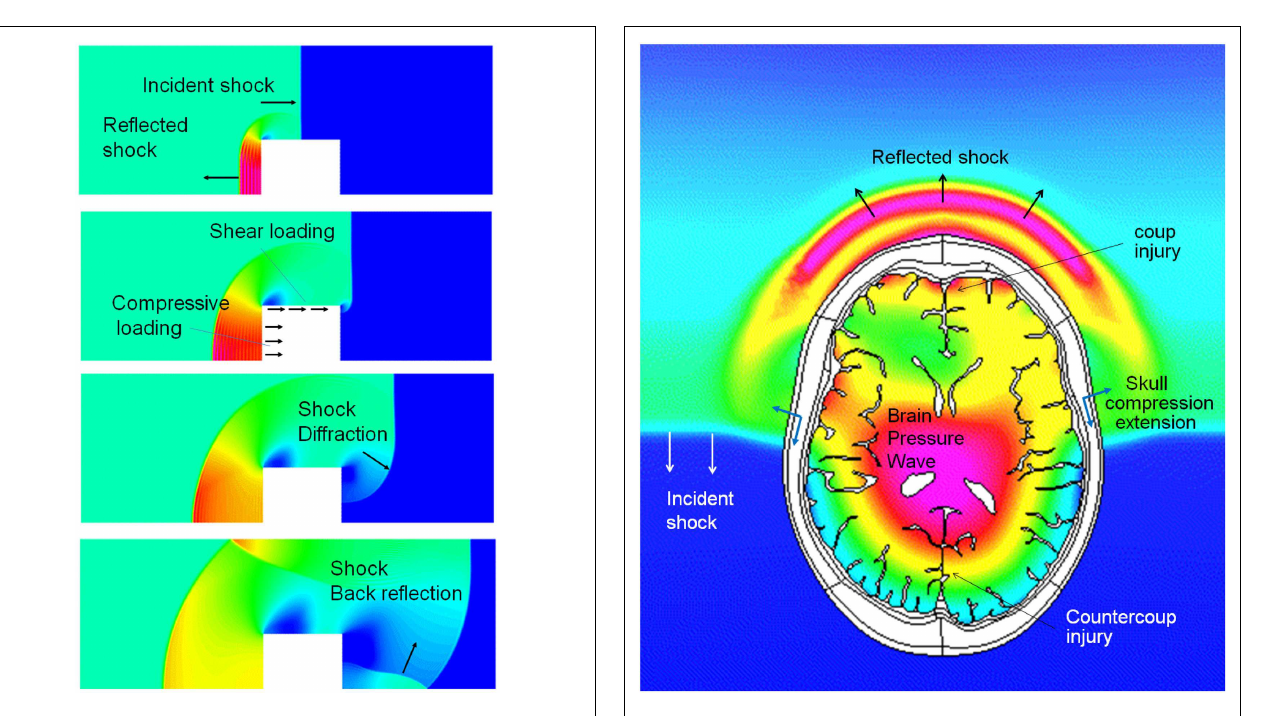
FIGURE 2 | CFD simulation of a blast wave impacting a sold block; four time instances of pressure fields showing shock reflection from the front face, diffraction around the block, and back reflection behind the block .